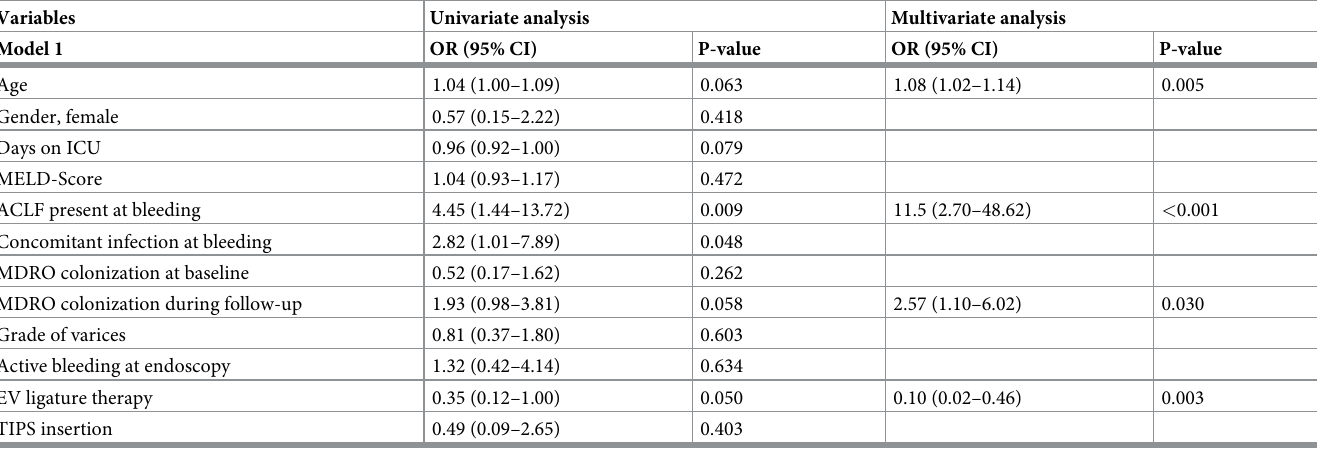
Table 3. Uni- and multivariate logistic regression analysis investigating risk factors for rebleeding within 10 days under antibiotic prophylaxis. Variables Univariate analysis Multivariate